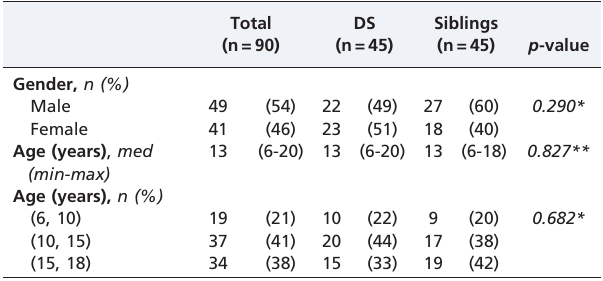
Table 1 - Age and gender characterization of the